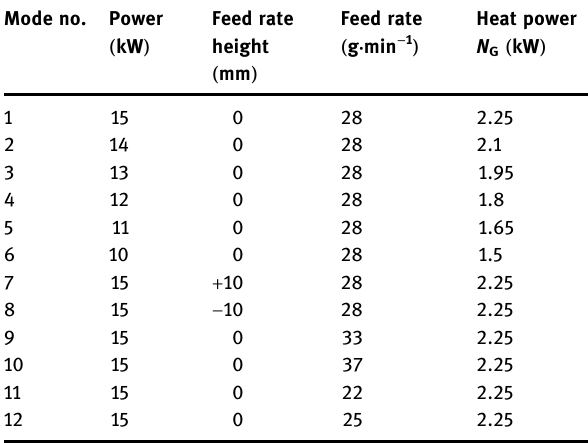
Table 1: Plasma spheroidization parameters Mode no. Power ( kW